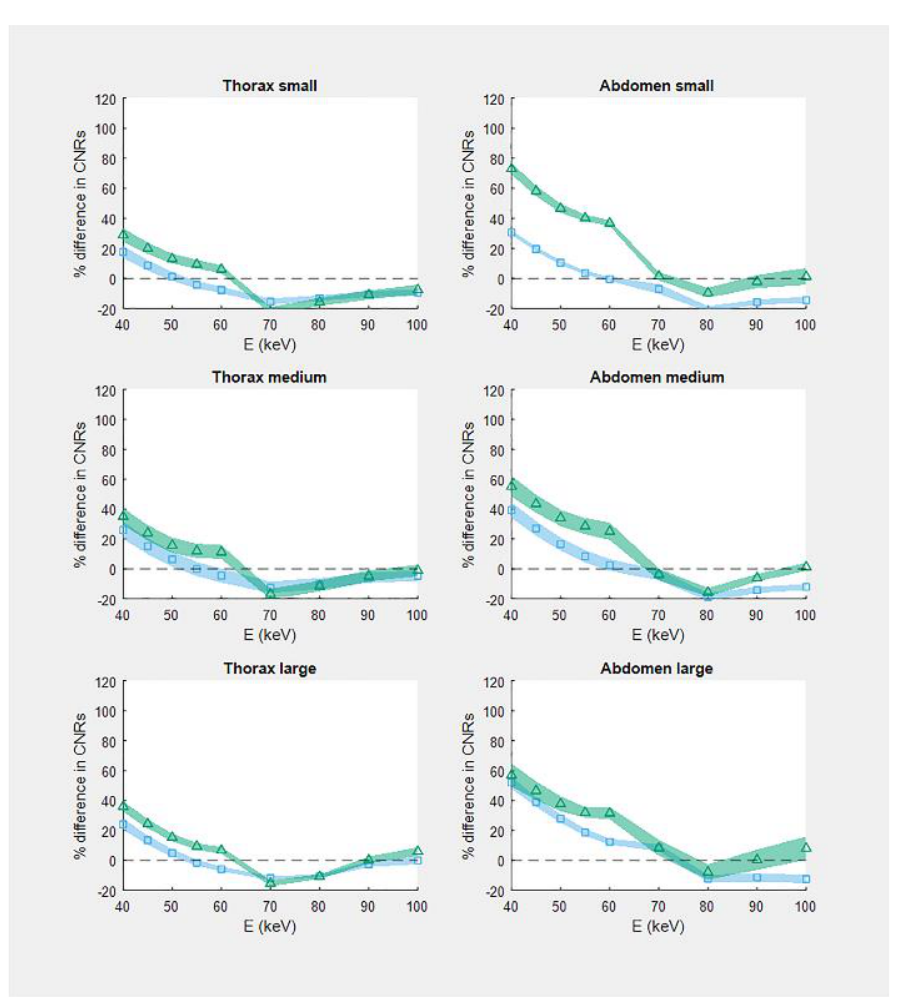
Figure 3. Relative CNR in virtual monoenergetic images reconstructed without iterative reconstruc- tion technique as a function of energy E (keV). For each phantom and energy, CNR of the PCD-based system is presented relative to the CNR of the EID-based system. Squares: single-energy 120 kVp PCD-CT. Triangles: single-energy 90 kVp PCD-CT. Symbols depict the estimated value and the accompanying shaded boundaries depict the standard error of this estimate.